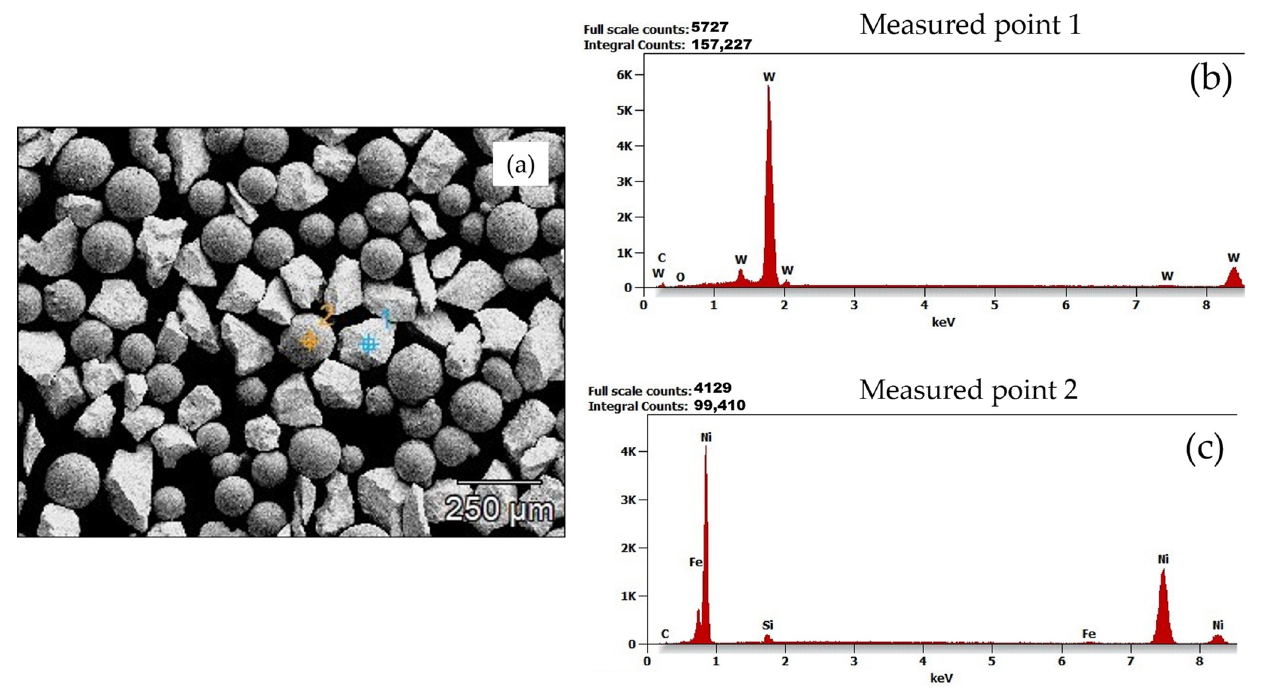
Figure 5. Microanalysis of powder particles ( a ) acquired SEM image of PG powder showing its morphology and measured points under analysis ( b , c ) Energy-dispersive X-ray spectrometry (EDS) diagrams of measured points 1 and 2. Table 4. Chemical composition in weight % and atom % of measured points of PG powder under analysis.